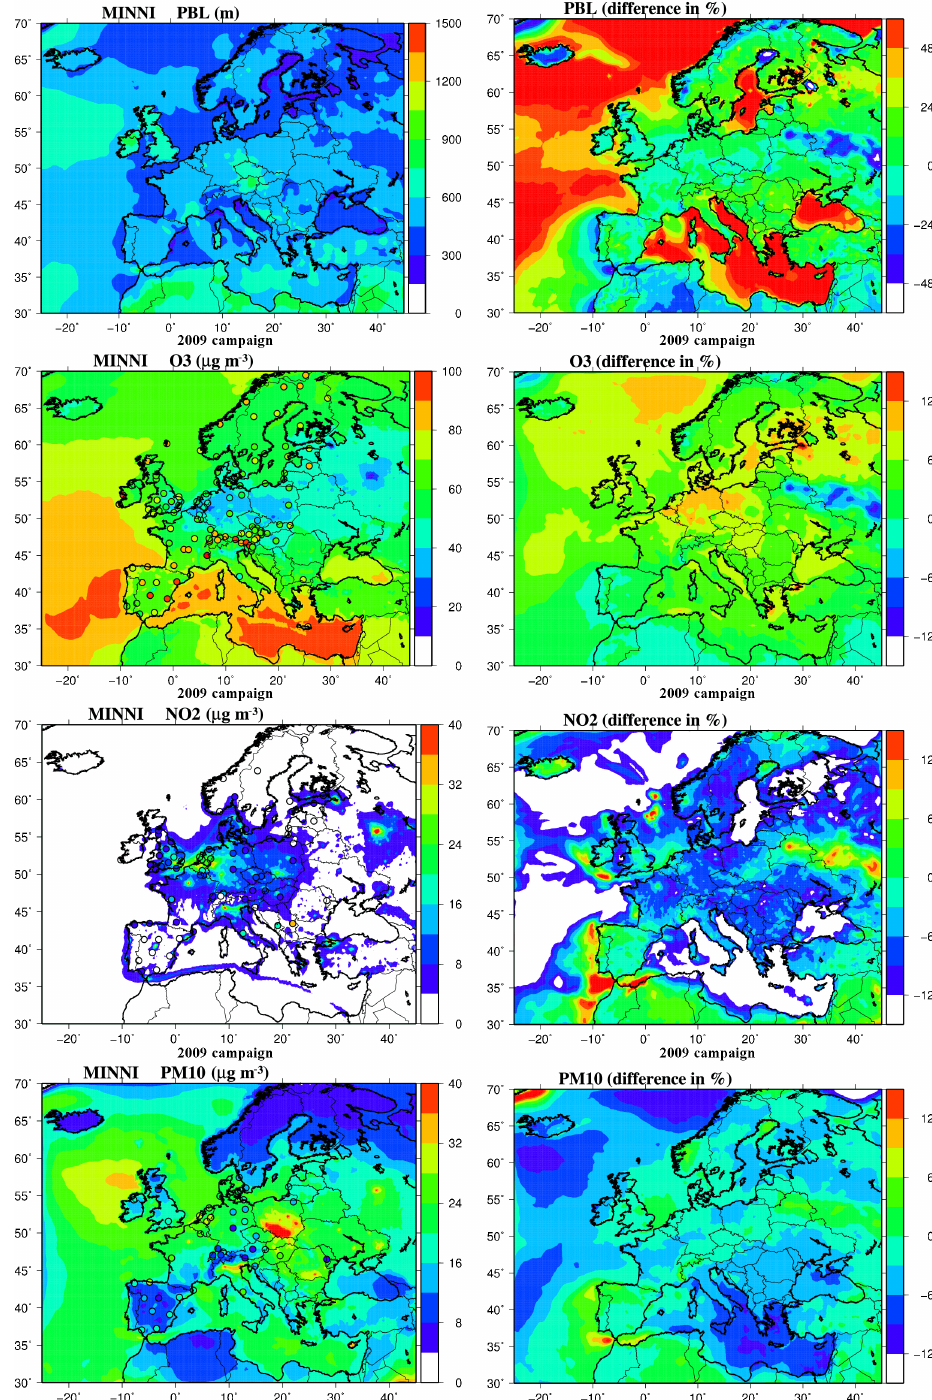
Figure 17. Left graphs show the average PBL heights and the average concentrations for O 3 , NO 2 and PM 10 using original MINNI’s parameterizations for the 2009 campaign. Right graphs show the percentage difference between the average concentrations calculated with PBL heights given by IFS (PBL IFS ) and by MINNI’s parameterizations (PBL MINNI ) . Red colour is assigned for values exceeding the colour